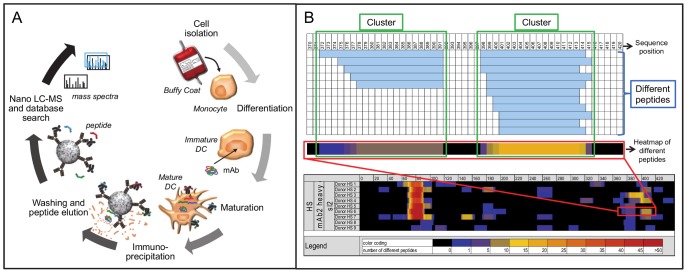
Illustration of MAPPs assay procedure and data output example.A: Illustration of MAPPs assay procedure. Monocytes are isolated from human buffy coats and differentiated to immature DCs in the presence of cytokines. Immature DCs are loaded with the model mAb and induced to maturation with lipopolysaccharide. After 24 hours, mature DCs are frozen. After lysis of mature DCs, HLA-DR:peptide complexes are isolated via immunoprecipitation using anti-HLA-DR coated beads. After several wash steps, peptides are eluted from HLA-DR complexes by pH shift and analysed by nano LC-MS with subsequent sequence identification via SEQUEST database search. B: MAPPs assay data output example. HLA-DR associated peptides can originate from different sequence regions of a protein and can occur in multiple length variants. Peptides in a sample with unique sequence are termed “different peptides”, highlighted with blue box. Nested sets of peptide length variants occurring within a sequence region sharing the same HLA-DR binding core are termed “clusters”, highlighted with green boxes. The number of different peptides per amino acid position can be summarized in a heatmap in which the cell colors are reflecting the number of different peptides, highlighted with red box. Different donors can differ in the pattern of presented peptides depending on binding propensities of their 2 HLA-DR alleles.